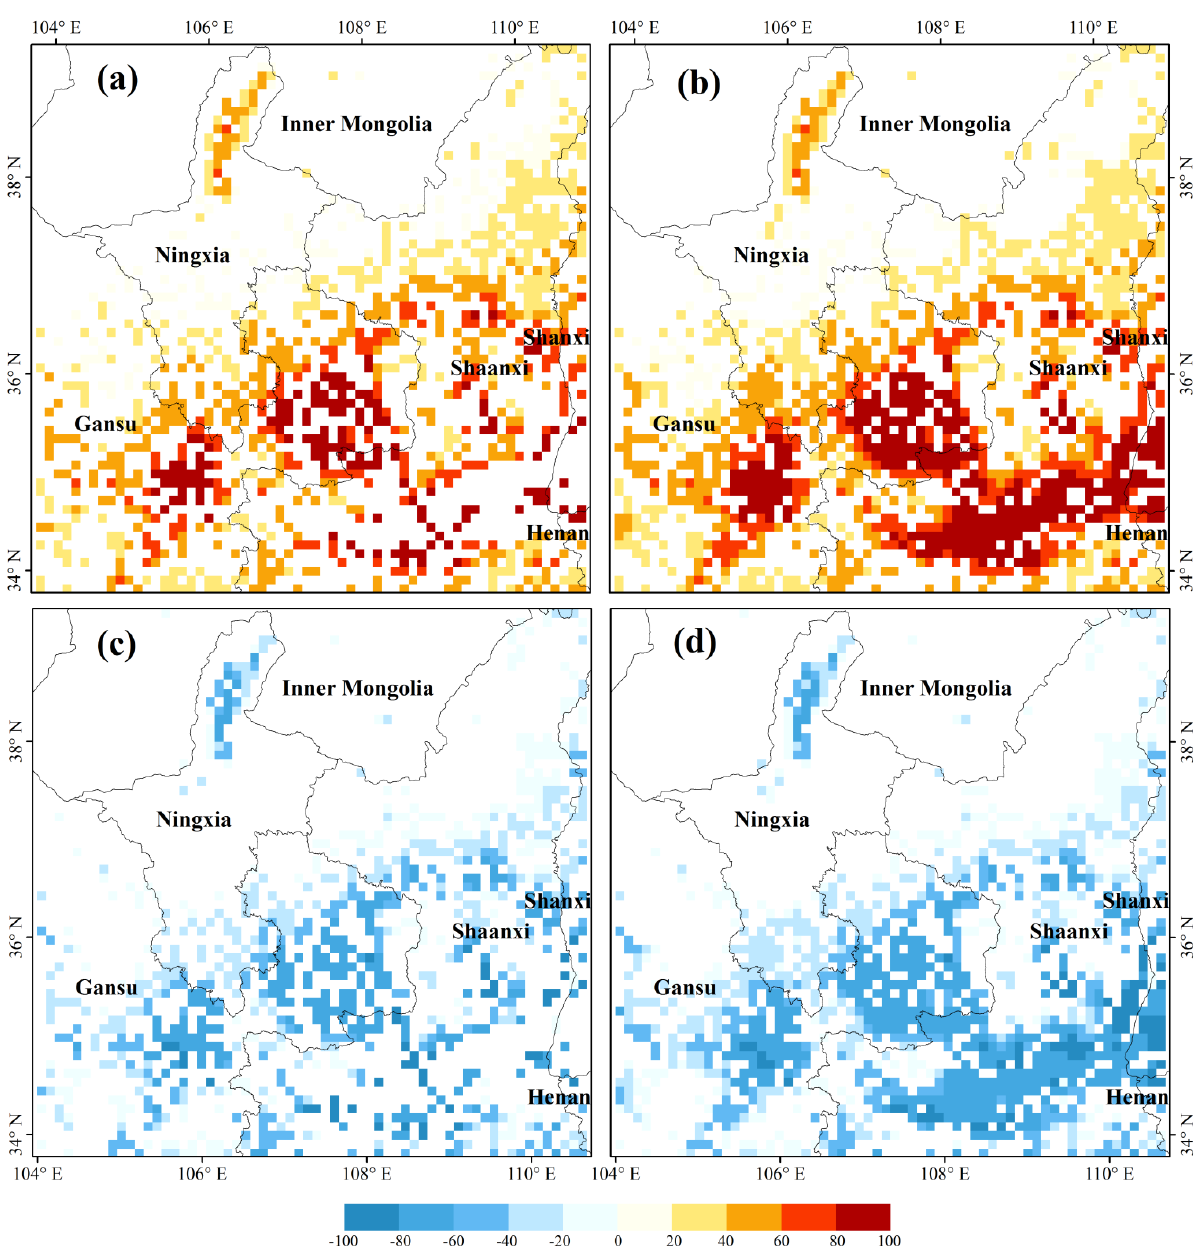
Figure 4. Annually-averaged differences in the latent heat fluxes (W m − 2 ): ( a ) the IRR-CON; and ( b ) the ICE-CON. Annually-averaged differences in the sensible heat fluxes (W m − 2 ): ( c ) the IRR-CON; and ( d ) the ICE-CON. All differences shown in the map are significant at a 95% confidence